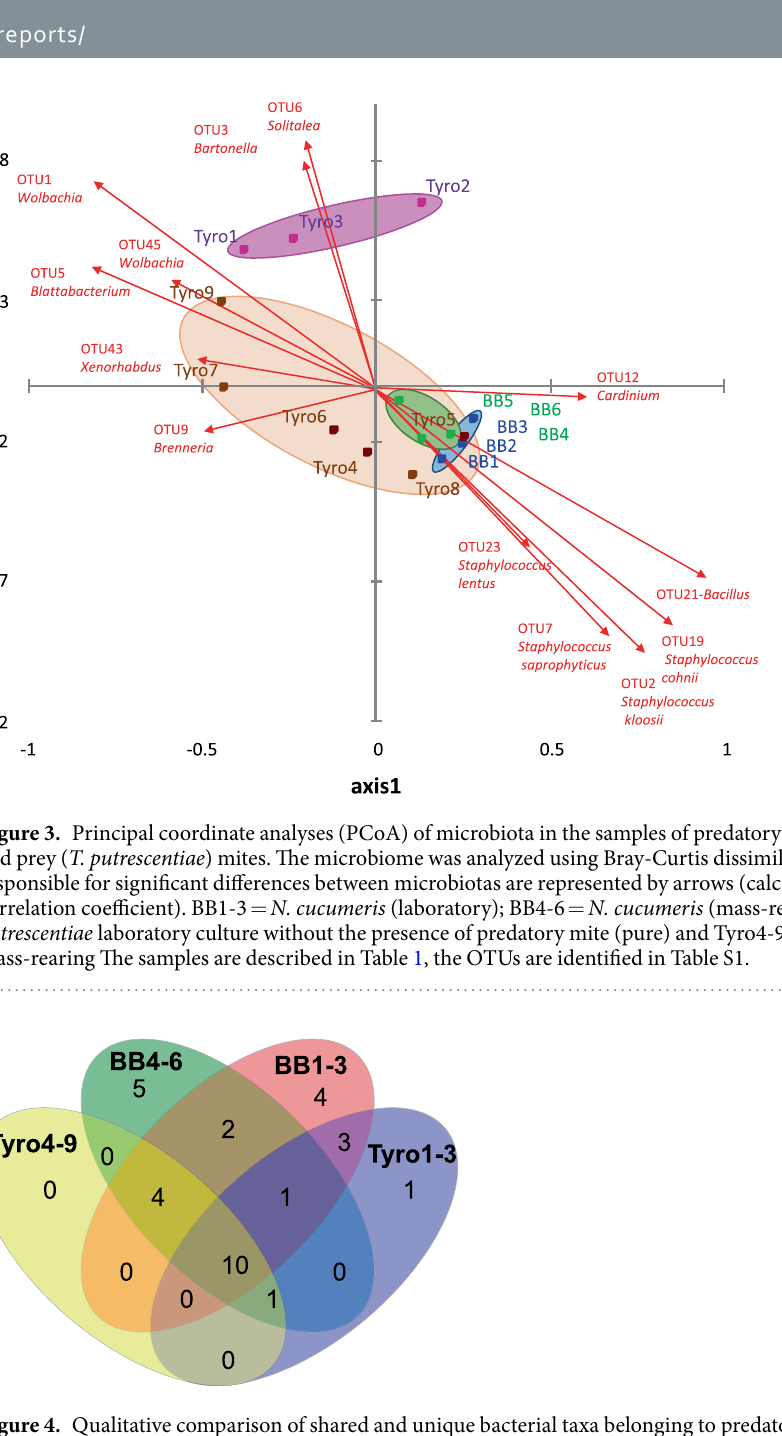
Figure 4. Qualitative comparison of shared and unique bacterial taxa belonging to predatory and prey mite microbiota by Venn diagram. The compared samples include predatory mites ( Neoseiulus cucumeris ) from the mass-production population (BB1-3) and the population with disease symptoms (BB4-6); the prey mites ( Tyrophagus putrescentiae ) from pure laboratory cultures without predators (Tyro1-3) and from the mass rearing production population with the presence of predators (Tyro4-9). The diagram was constructed from the core species per samples. The shared OTUs among all samples were the following taxa ordered by decreasing relative abundance: Staphylococcus kloosii (OTU2), Wolbachia (OTU1), Blattabacterium- like (OTU5), Bartonella -like (OTU3), Solitalea -like (OTU6), Staphylococcus saprophyticus (OTU7), Staphylococcus cohnii (OTU19), Bacillus cereus (OTU21), Cardinium (OTU12), Brevibacterium siliguriense (OTU16). Brenneria (OTU9), Staphylococcus lentus (OTU23), Kocuria koreensis (OTU25) and Xenorhabdus innexi (OTU43) were shared by predatory mites (BB1-3 and BB4-6) and prey mites from the mass rearing production population (Tyro4-9). Wolbachia (OTU45) was shared by predatory mites (BB1-3 and BB4-6) and prey mites from pure laboratory cultures without predators (Tyro1-3). Arthrobacter (OTU47) was shared by predatory mite population with disease symptoms (BB4-6) and both populations of the prey mites (Tyro1-3 and